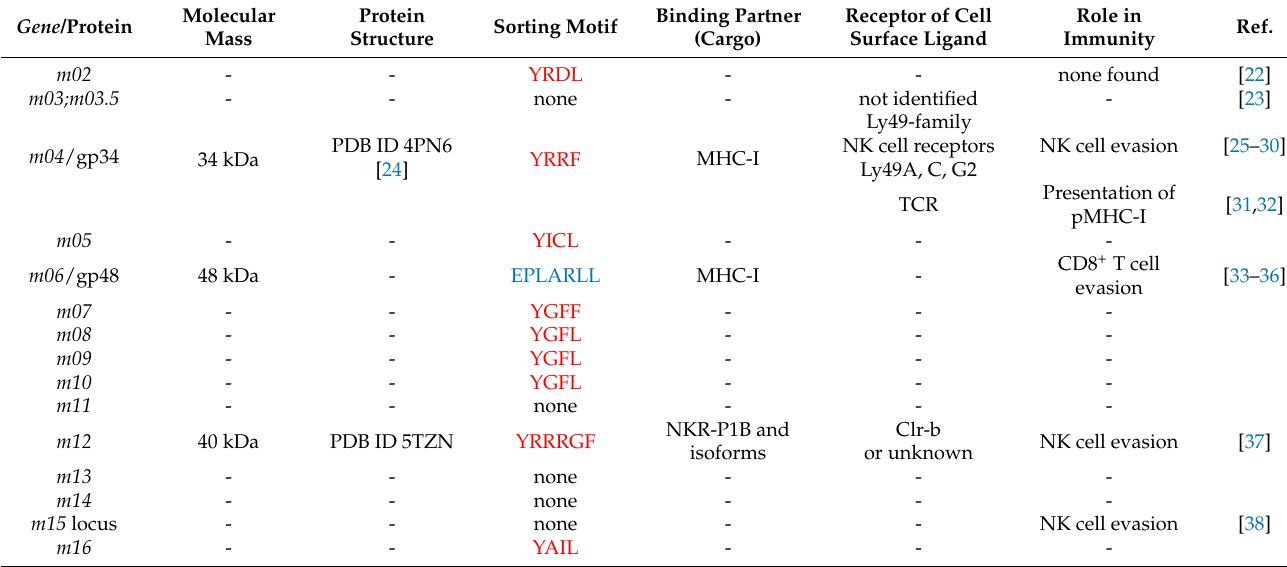
Table 1. Members of the m02 gene family. Experimentally determined molecular masses refer to the most prevalent glycosylated isoforms. (-) not studied or not applicable; (Red) cytoplasmic tail YXX Φ (where Φ is a hydrophobic amino acid residue) cargo sorting motif for binding to cellular adapter proteins AP-2 and/or AP-4; (Blue) cytoplasmic tail di-leucine cargo sorting motif [D/E](X)XXXL[L/I] for binding to cellular adapter proteins AP-1 and/or AP-3; (NK) natural killer; (PDB ID) Protein Data Bank identification code; (TCR) T cell receptor; (TMD) transmembrane